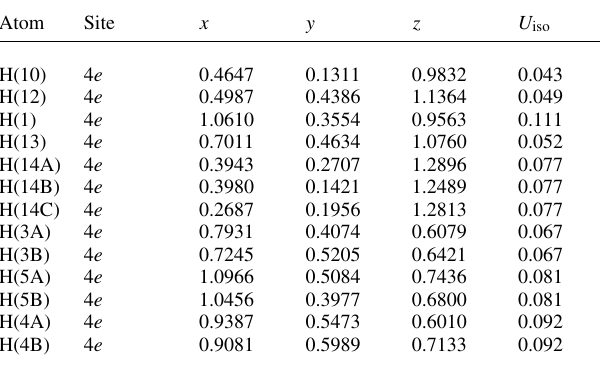
Table 2. Atomic coordinates and displacement parameters (in Å 2 ) .